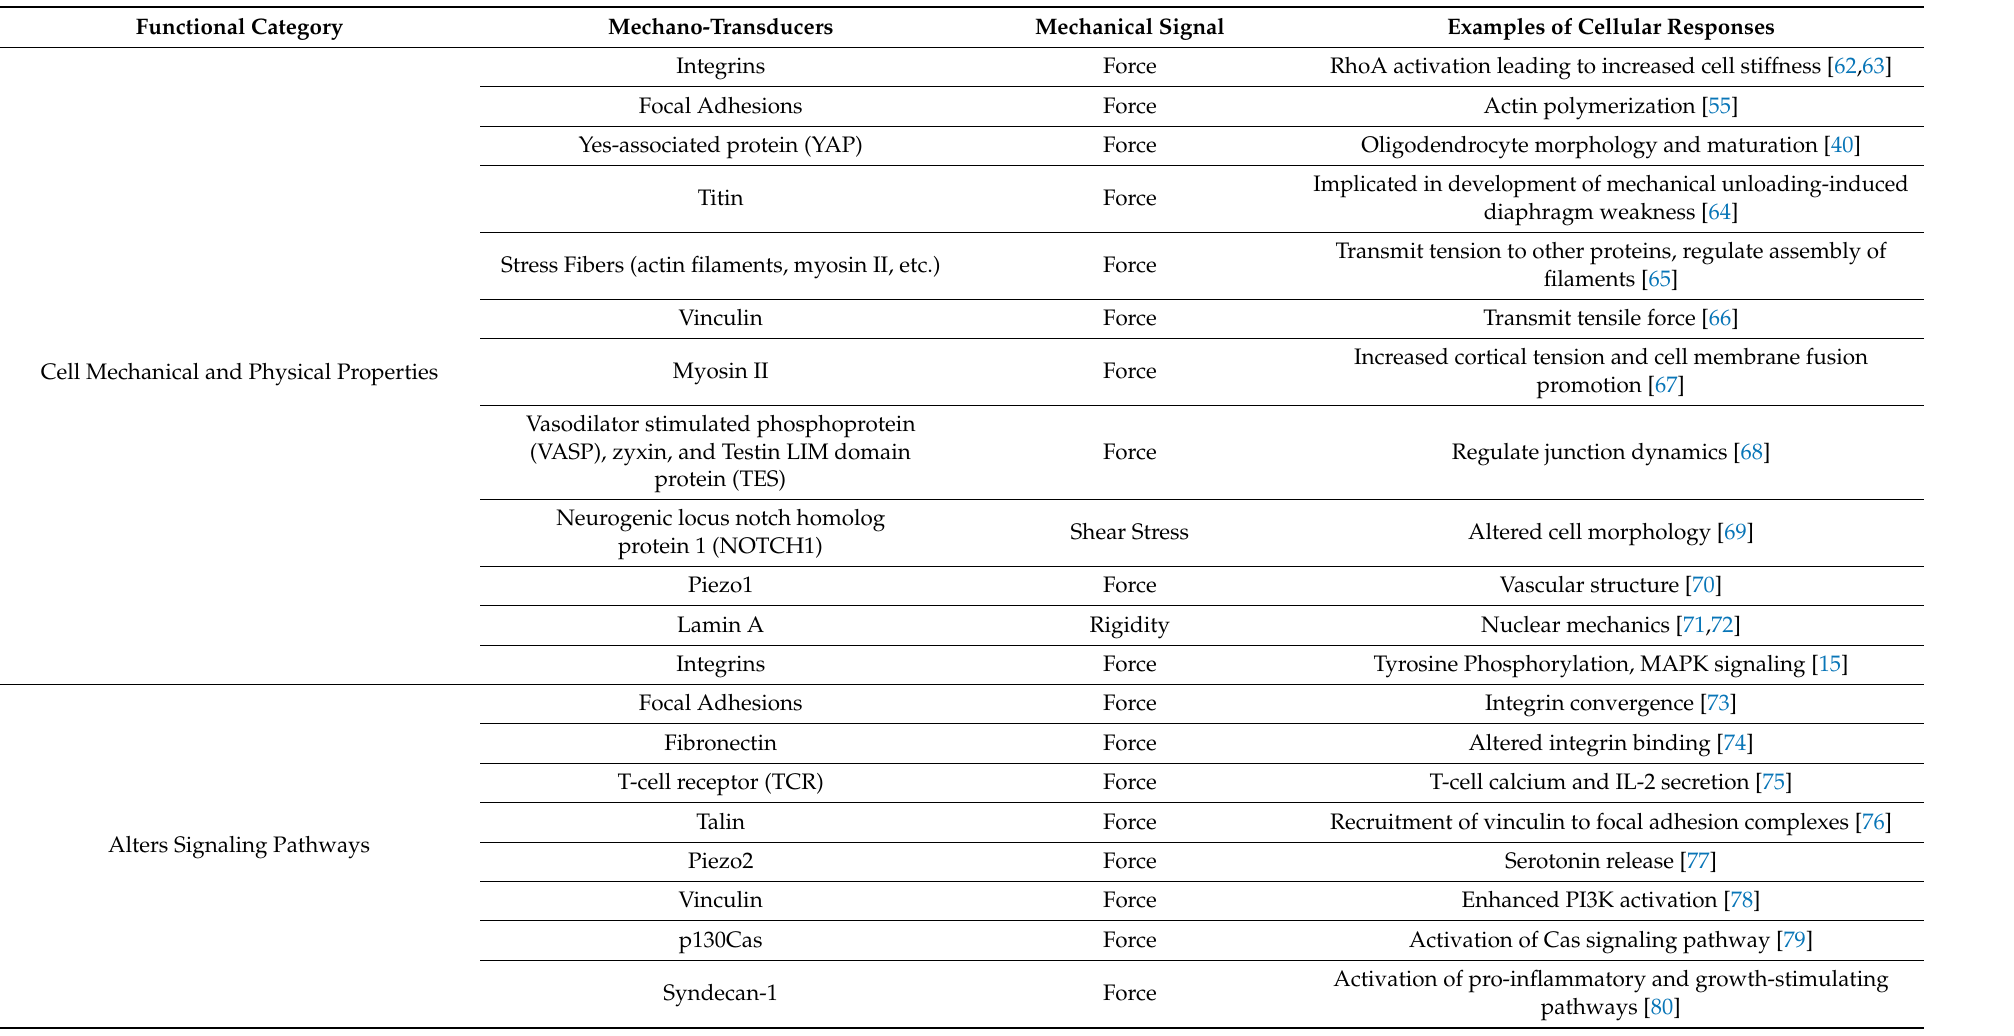
Table 1. Mechanotransducers of various mechanical properties and human cellular